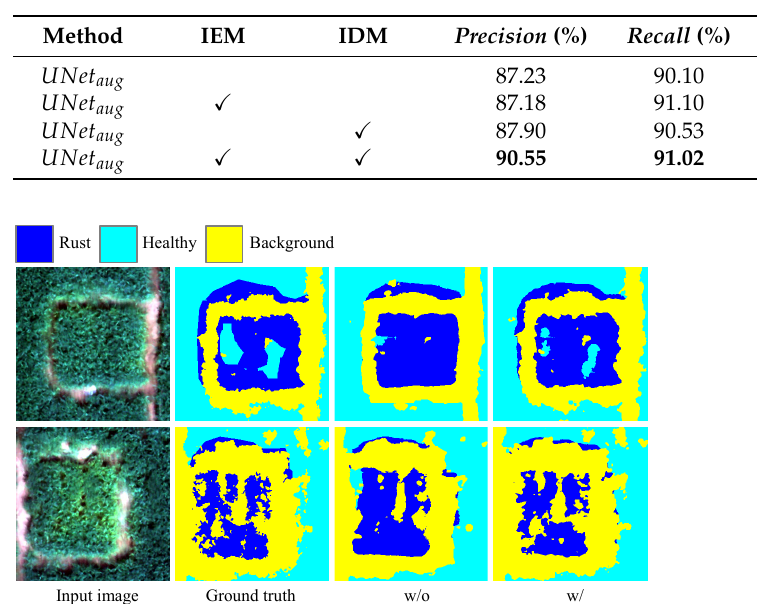
Figure 12. Segmentation maps of input image, ground truth, results without modules (w/o) and results with modules (w/) ( left to right